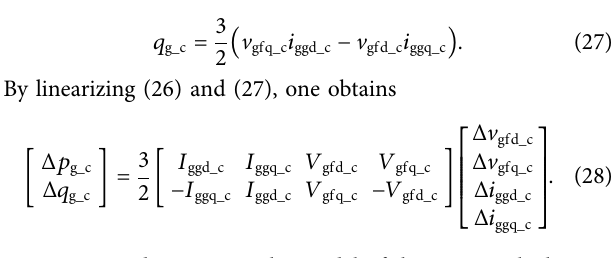
Figure 2G,H demonstrate the model of the power